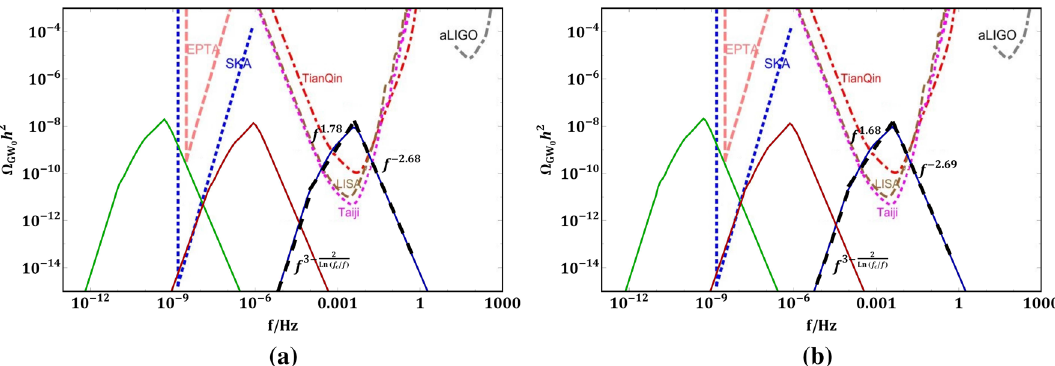
Fig. 7 a TheinducedGWsenergydensityparameter (cid:3) GW , 0 versusthe frequency in the quartic inflation model for the cases A H (blue line), B H (red line), and C H (green line). b Same as a but in the natural infla- tion model for the cases A N (blue line), B N (red line), and C N (green line). The black dashed line denotes the broken power-law behaviour